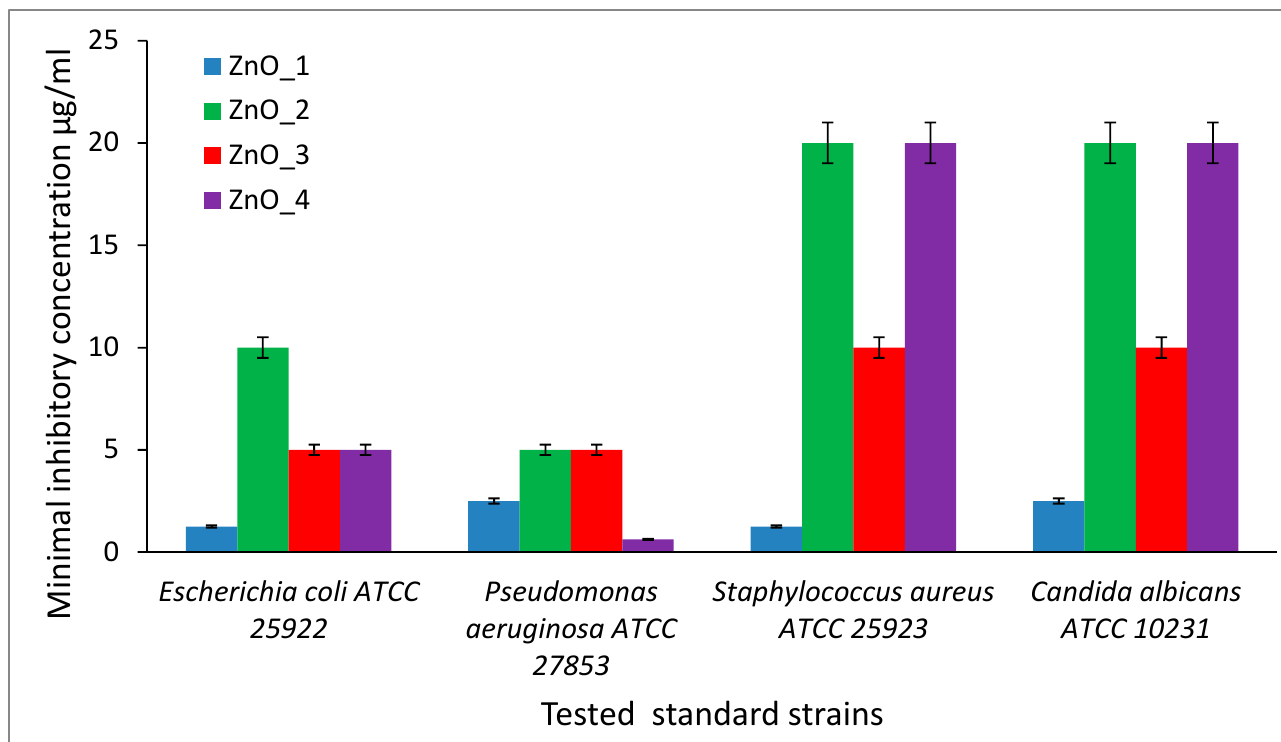
Figure 12. Minimal inhibitory concentration values (µg/mL) for the ZnO nanoparticles prepared with various capping agents against tested strains. ZnO_1 = sample synthesized in an alkaline medium without capping agent, ZnO_2 = synthesized in an alkaline medium in the presence of CTABr, ZnO_3 = synthesized in an alkaline medium in the presence of plant extract and ZnO_4 = synthesized only in the plant extract.